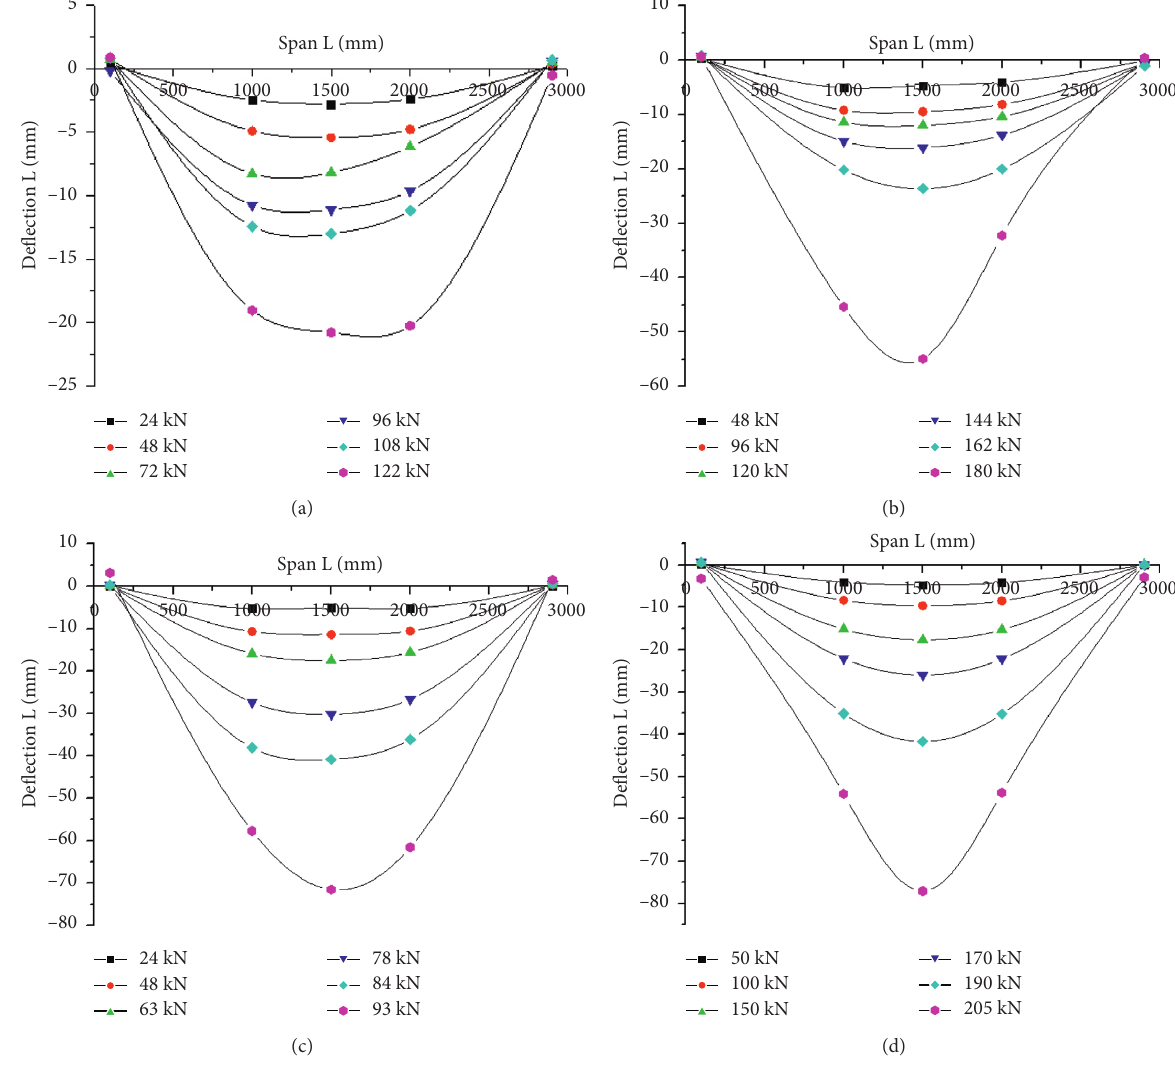
Figure 12: Test beam overall deformation curve. (a) L-1, (b) L-2, (c) L-3, (d)